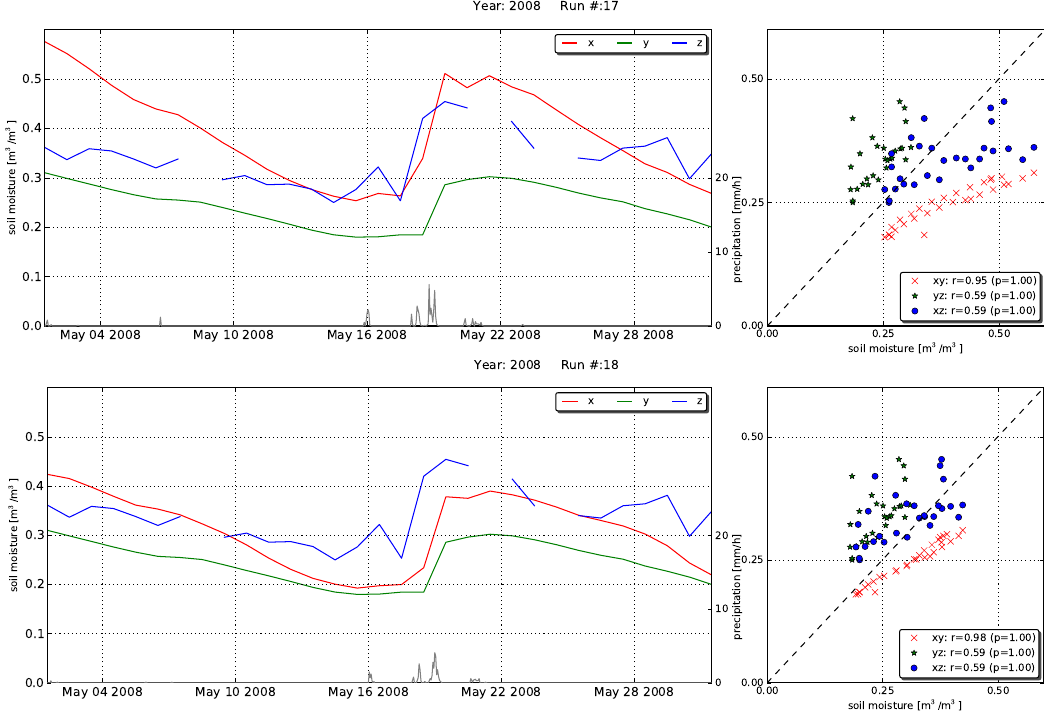
Fig. 8a. Details of soil moisture time series for stations Lochheim #17 and Steinbeissen #18 (red), model (green) and satellite (blue). Correlations r between the time series and their respective significance p are provided. Information on precipitation dynamics is provided